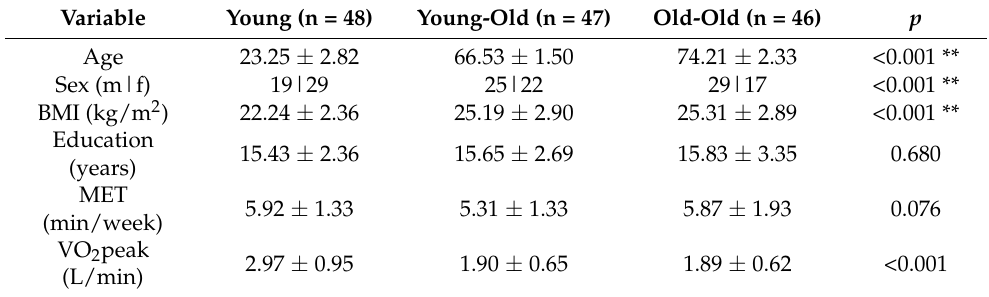
Table 1. Demographic